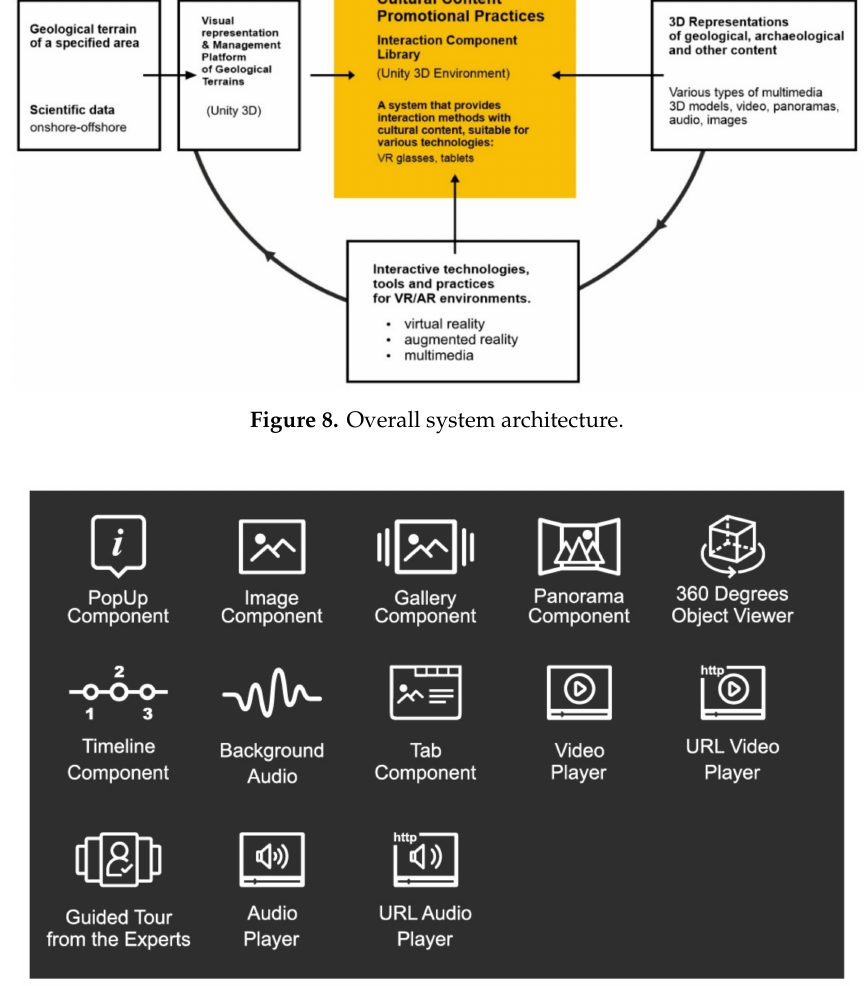
Figure 9. The Interaction Component Library: List of Interaction Components created for the VIRTUALDiver platform accompanied by their respective